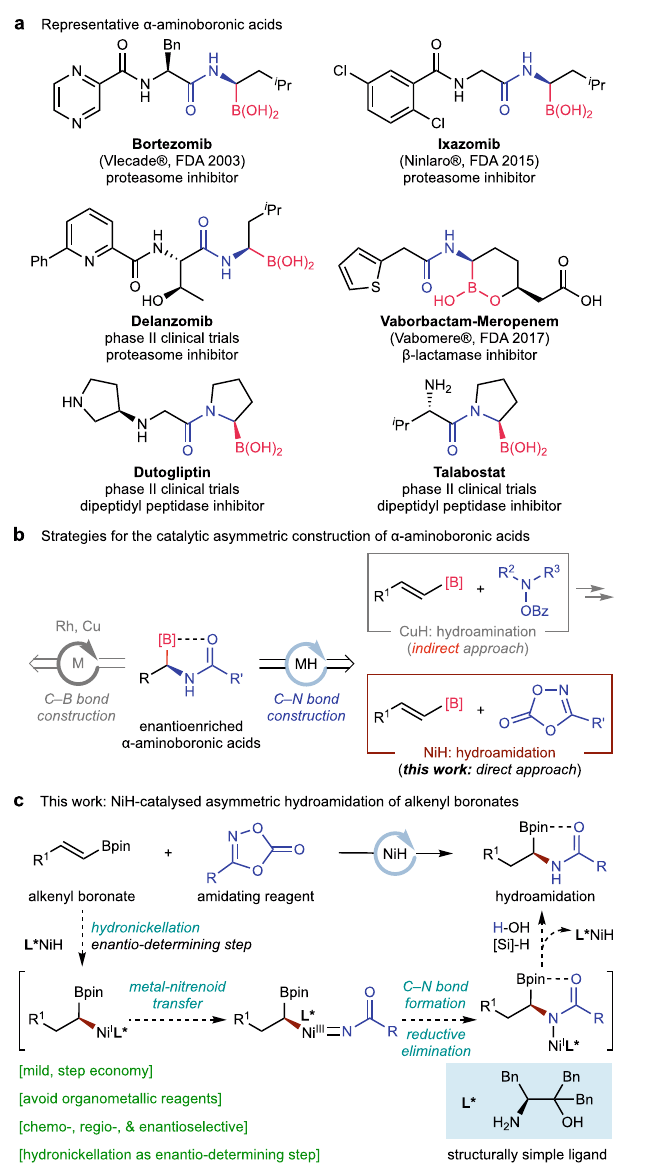
Fig. 1 | Design plan: NiH-catalysed asymmetric hydroamidation to access bioactive chiral α -aminoboronic acids. a Representative α -aminoboronic acids. b Strategies for the catalytic asymmetric construction of α -aminoboronic acids.